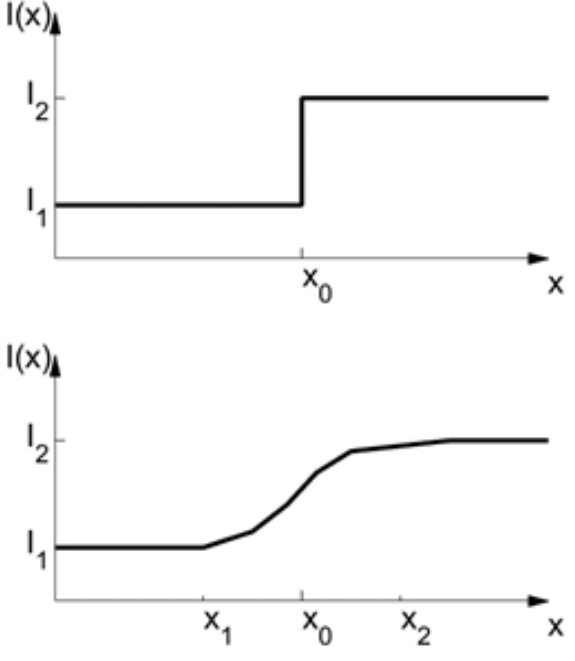
Figure 6: Illustration of the edge a) perfect edge, b) blurred